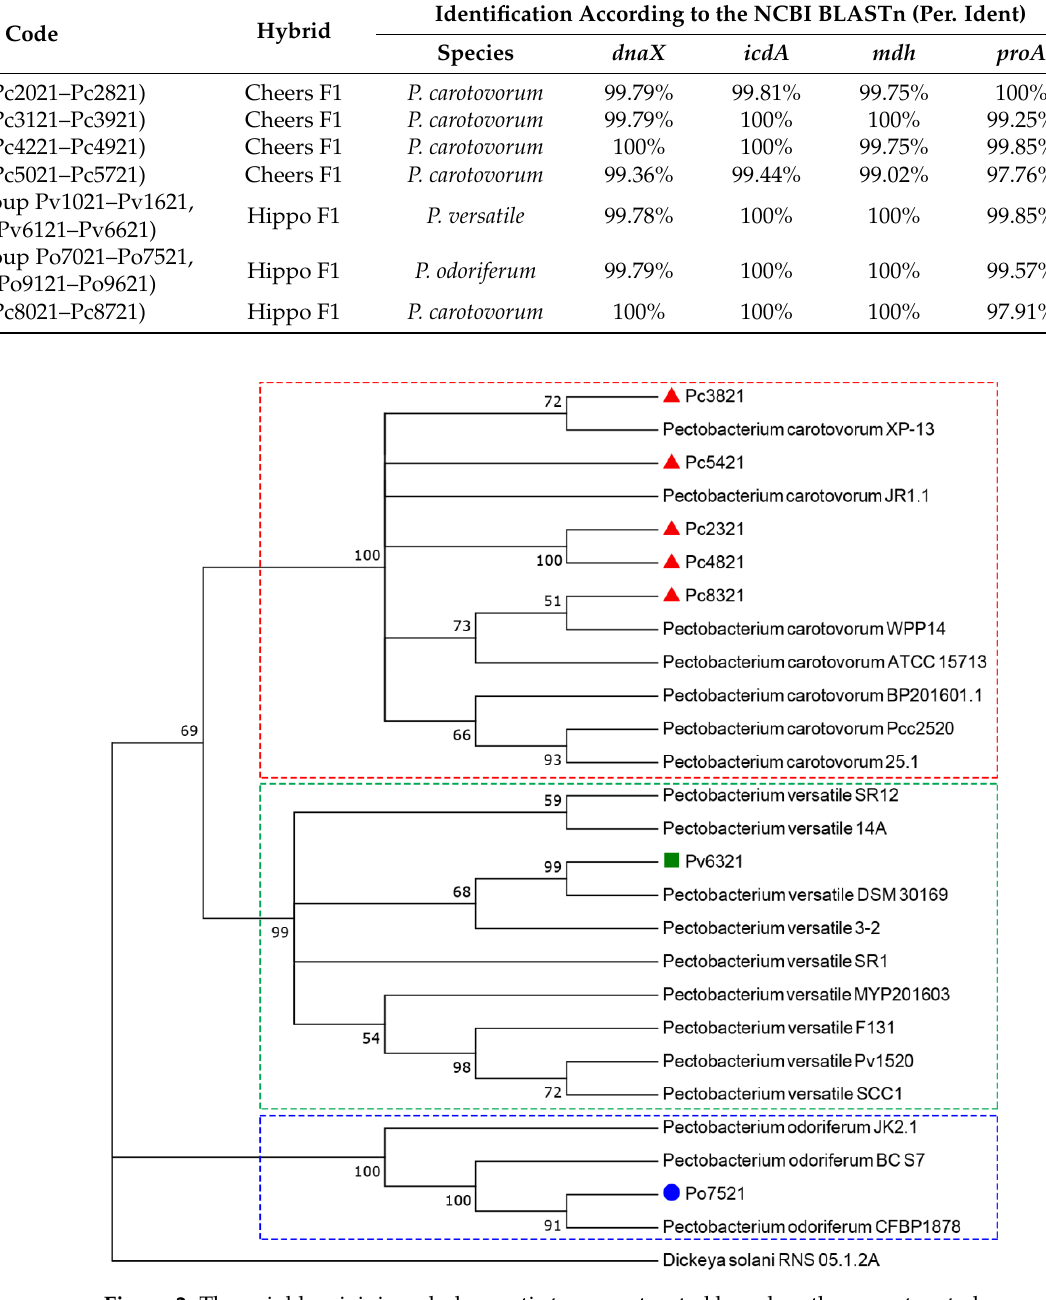
Figure 2. The neighbor-joining phylogenetic tree constructed based on the concatenated sequences of genes dnaX , icdA , mdh , and proA for seven representative P. carotovorum , P. odoriferum , and